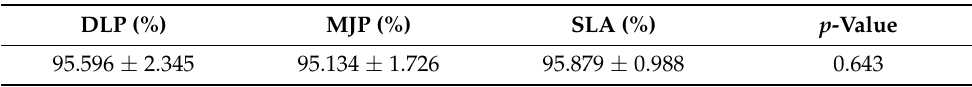
Table 6. The inTOL (%) of precision (mean ± SD) for 3D-printed models ( n = 30). DLP (%)